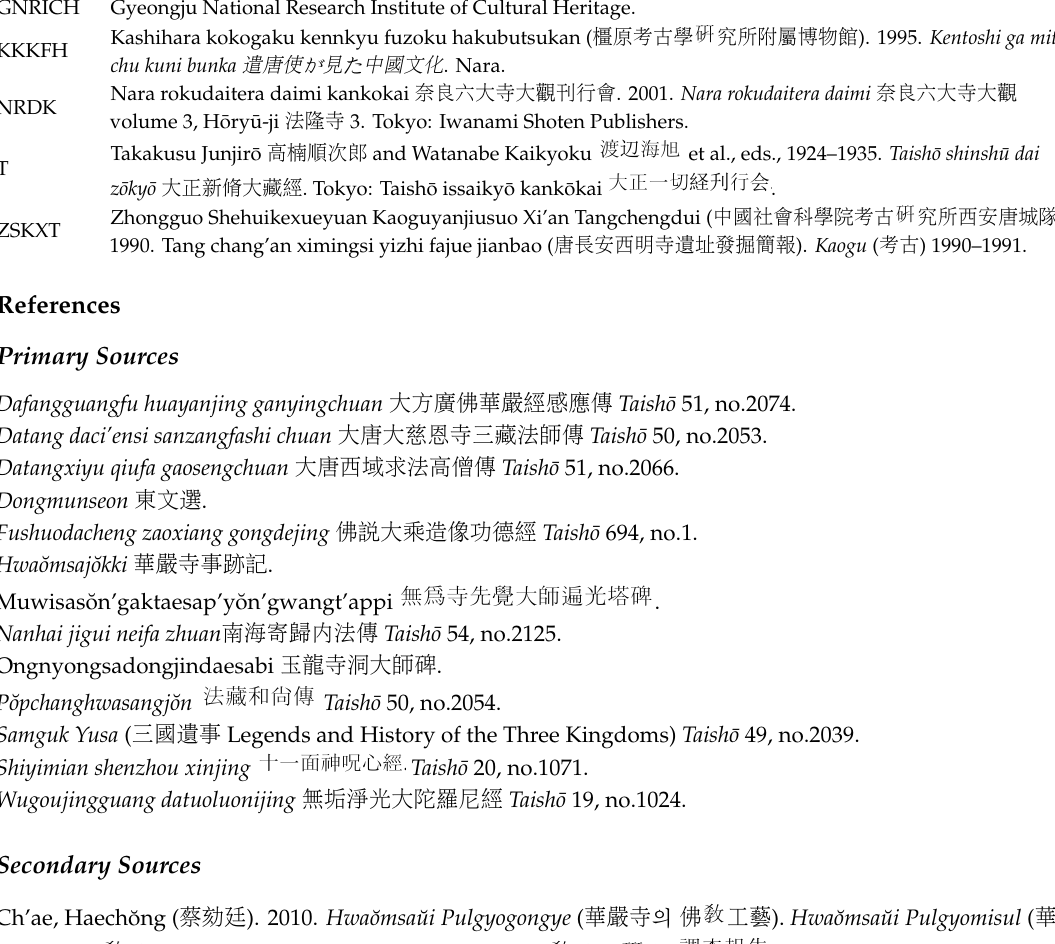
Figure 20. Clay Buddha, Pagan period, 12th–13th centuries, 9.6 × 7.1 cm, Myanmar [Source: (Fukuoka Art Museum 2008, cover picture)].